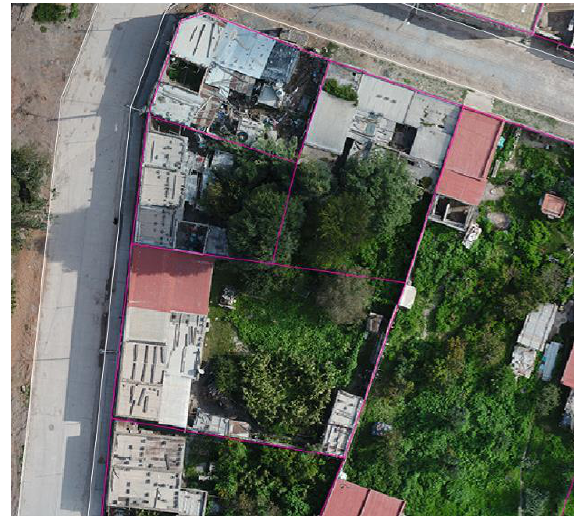
Figure 6. Detail of Cadastral Map